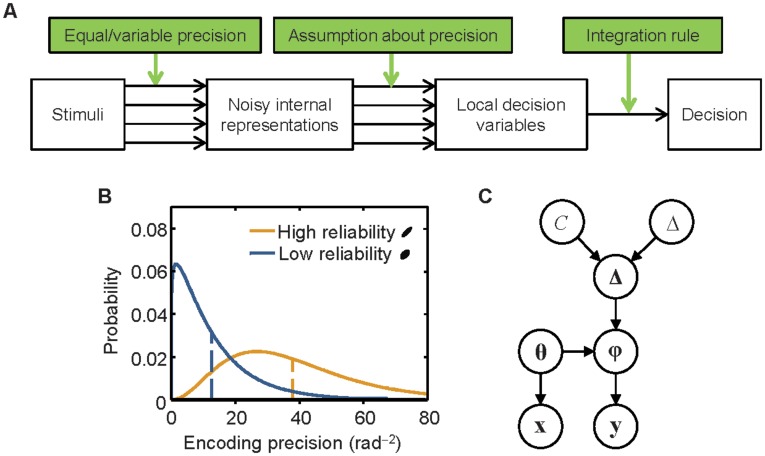
A, Flow diagram of the decision process.Models differ along three dimensions: whether precision is equal or variable, the observer’s assumption about precision, and the observer’s integration rule. B, Examples of probability density functions over encoding precision for a high-reliability and a low-reliability stimulus (long and short ellipse, respectively) in the variable-precision model. Dashed lines indicate the means. C, The generative model shows statistical dependencies between variables. C: change occurrence (0 or 1); Δ: magnitude of change; Δ: vector of change magnitudes at all locations; θ and ϕ: vectors of stimulus orientations in the first and second displays, respectively; x and y: vectors of measurements of the stimulus orientations. The spatial, temporal, and structural complexities of the task can be recognized in the vector nature of the orientation variables, the two “branches”, and the number of layers, respectively.